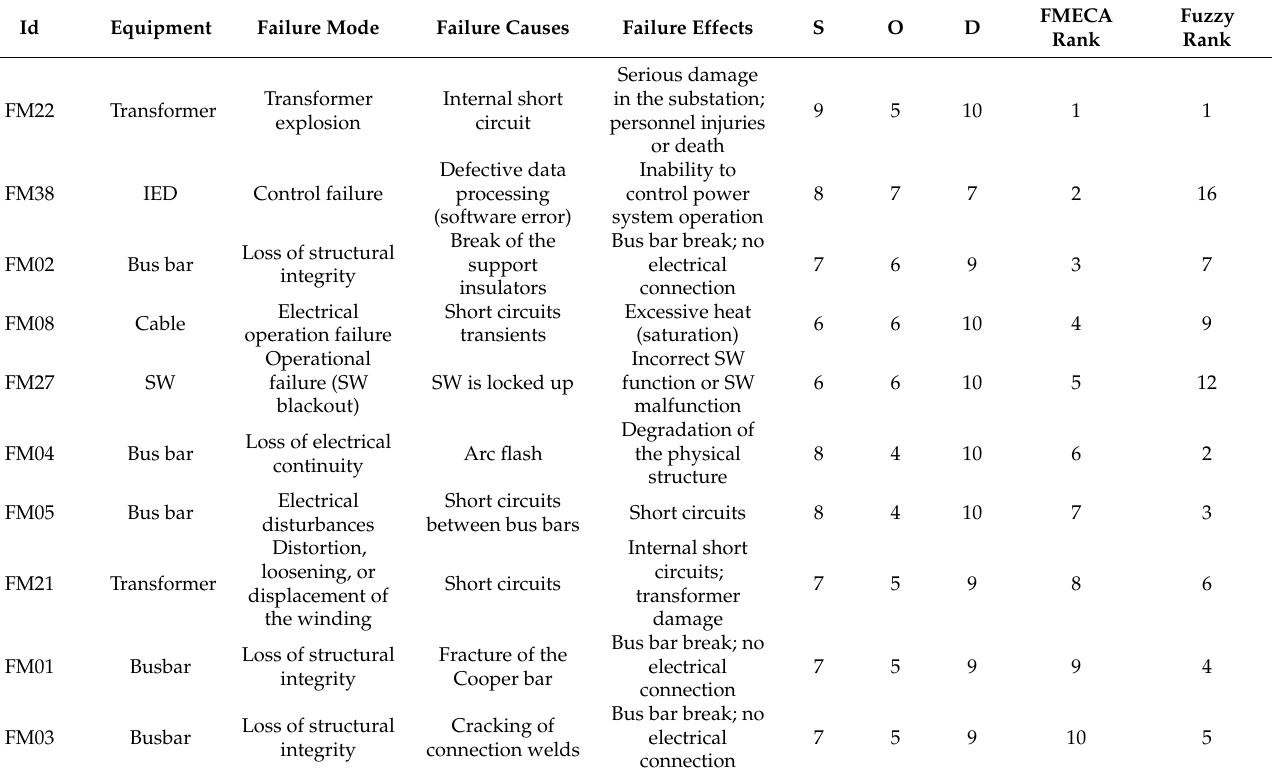
Table 11. Comparison between the top ten classical FMECA rankings and those obtained using the proposed fuzzy-based